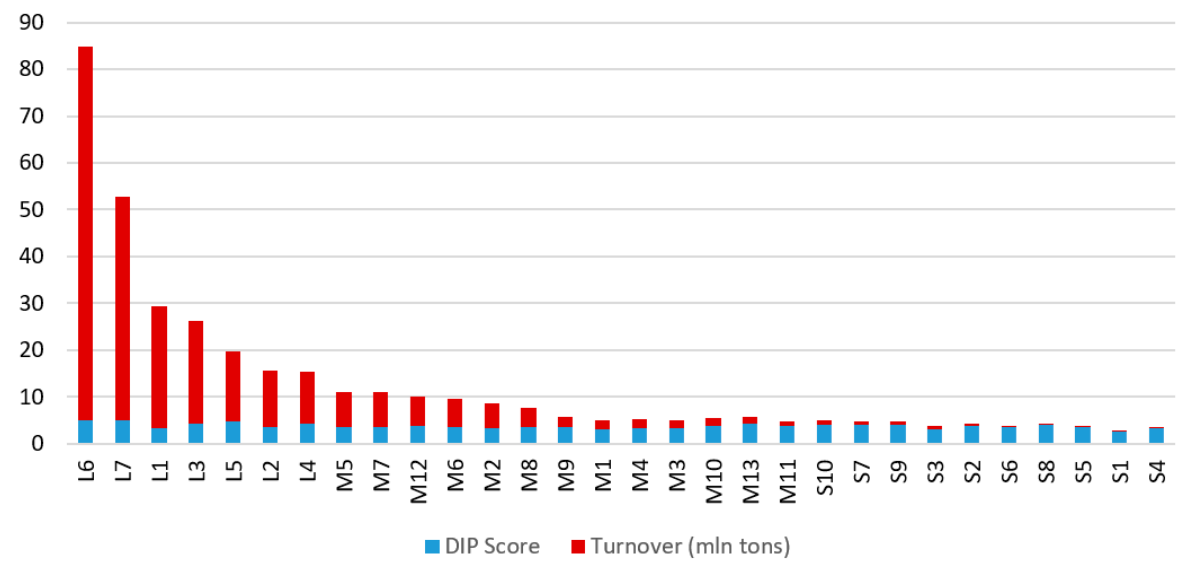
Figure 8. Ranking of analysed ports’ DIP score.